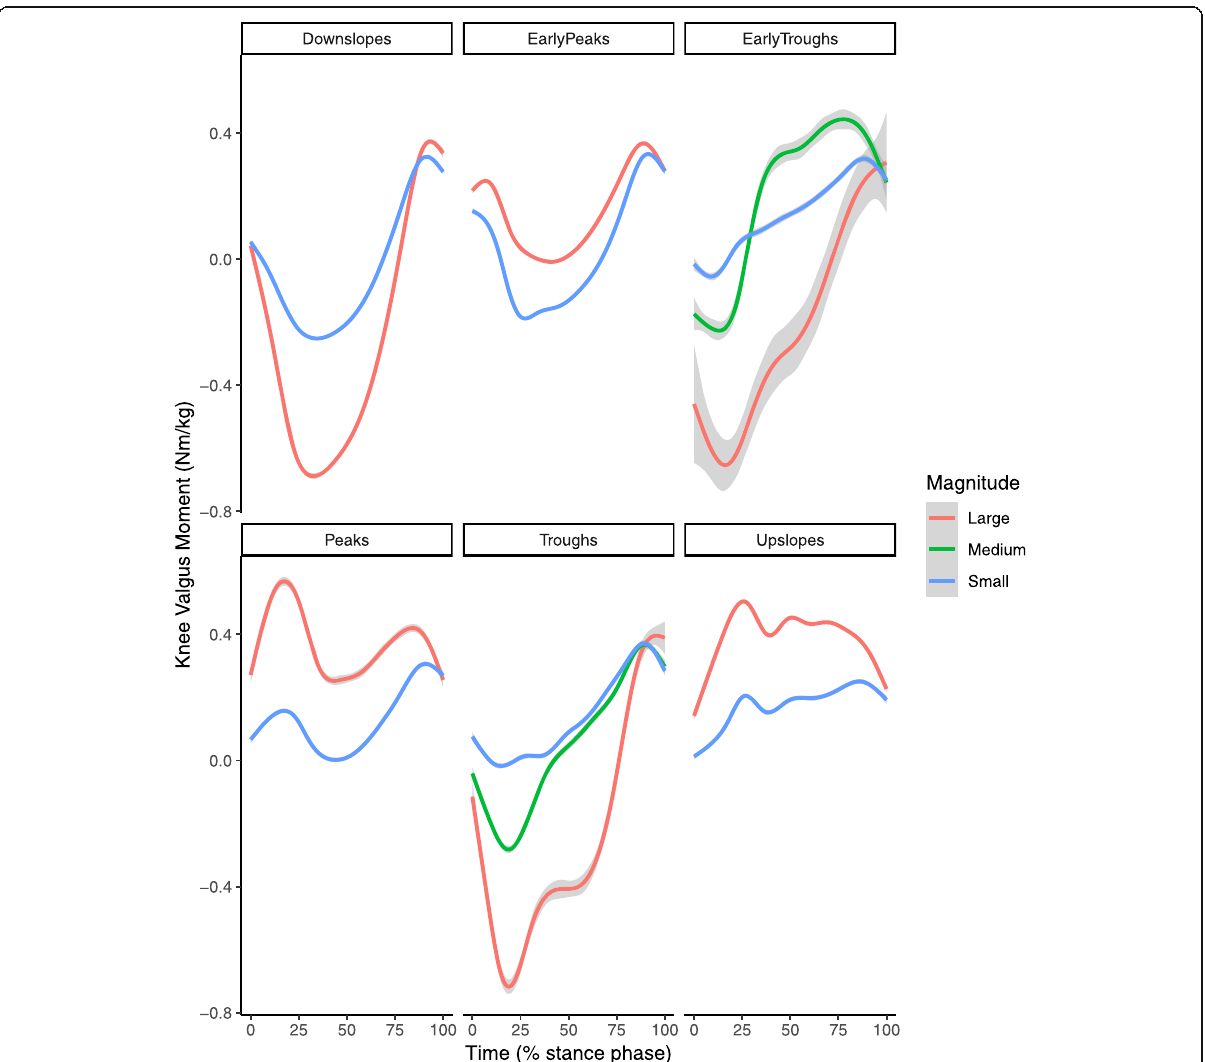
Fig. 6 Smoothed aggregates of the time series of the whole stance phase of all clusters generated with the two step cluster analysis. The gray area denotes the 95% confidence interval from the smoothing